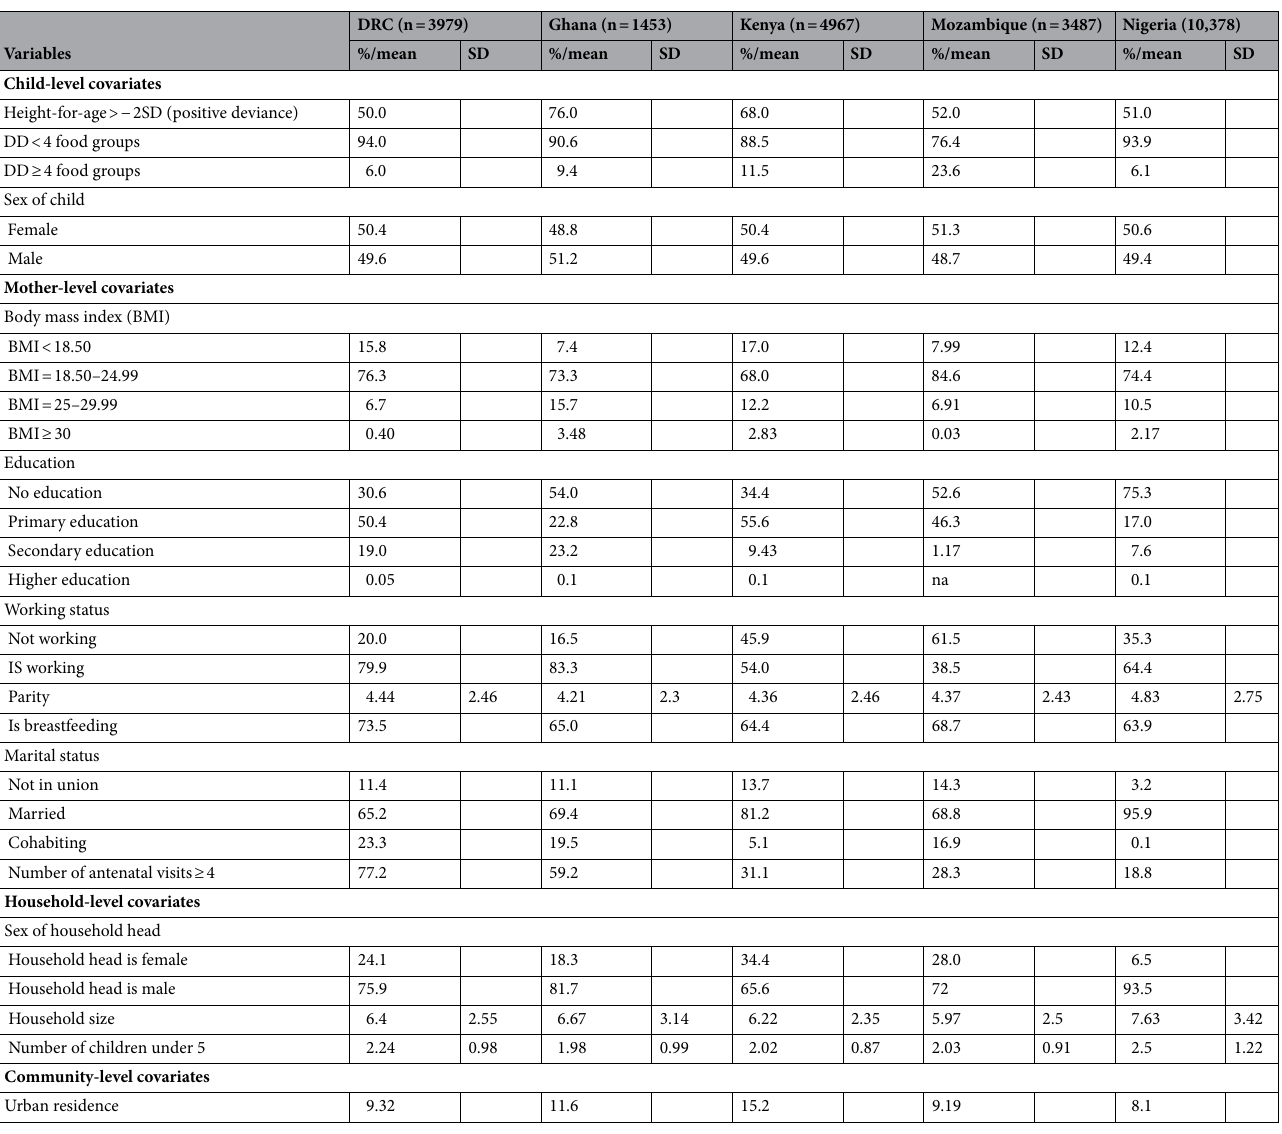
Table 1. Characteristics of the study variables of the five countries. DD dietary diversity, DRC Democratic Republic of Congo, SD standard